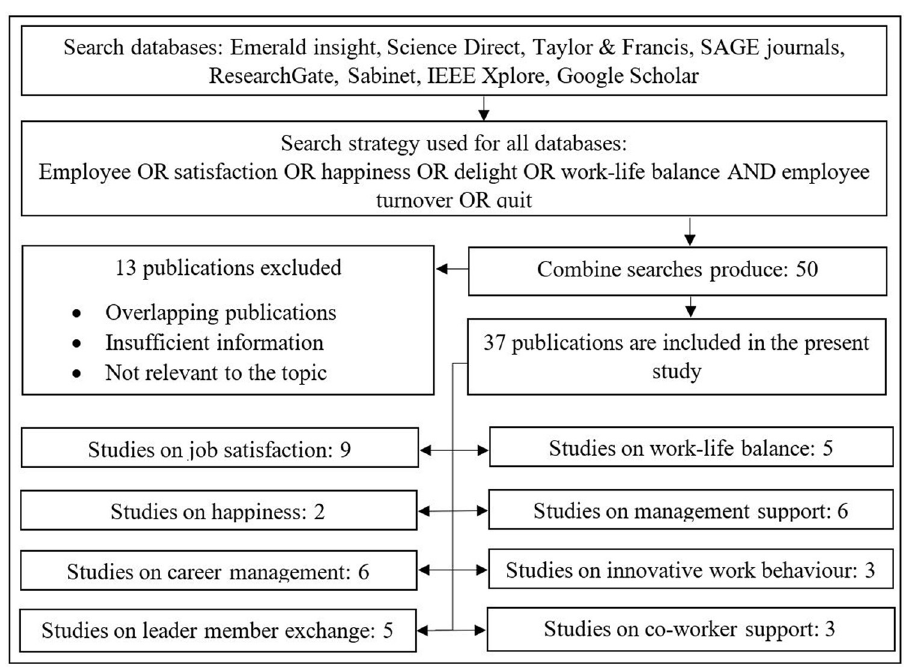
Fig 1. Literature search flow diagram. Source: Based on authors’